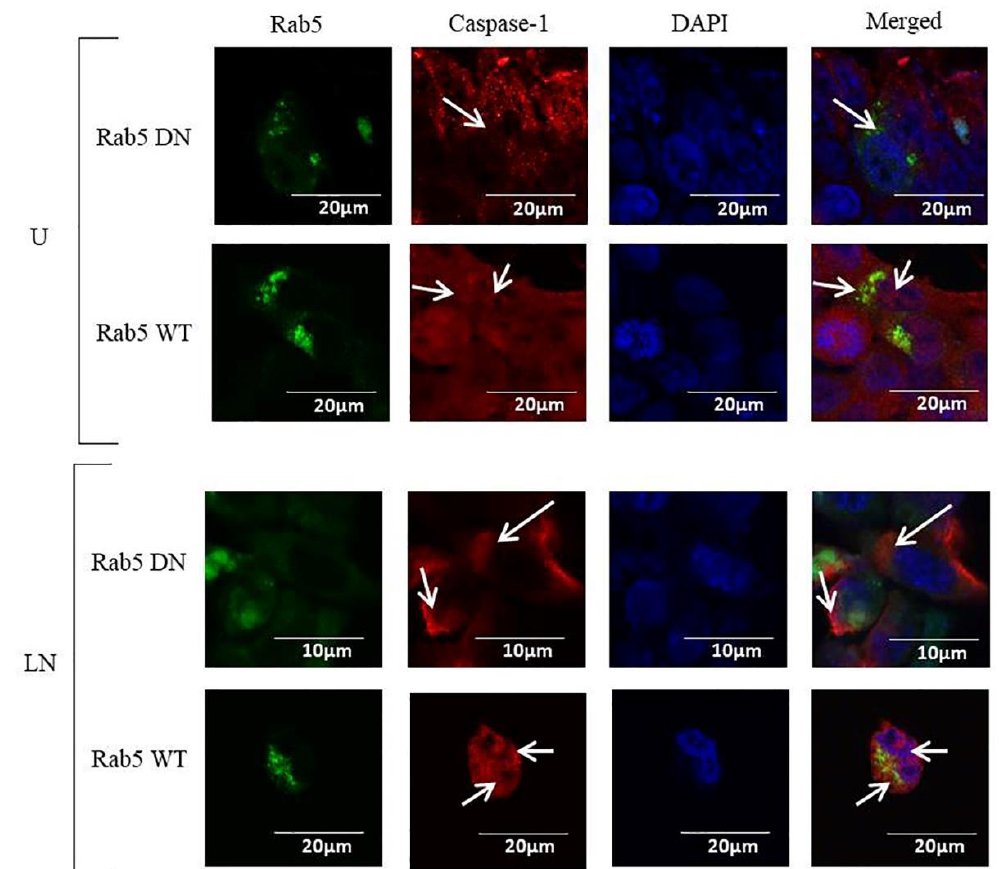
Figure 3. The e ff ects of Rab5 DN and Rab5 WT expression on caspase-1 localization. Nigericin (20 µ M) treatment for 24 h and three hours of pre-incubation with LPS (1 µ g / mL) were used to activate the NALP3 inflammasome after the transfection of pDsRed-rab5-WT and pDsRed-rab5-DN to the HCT116 cells. Caspase-1 was found only in the cytosol in the control and LPS / nigericin-treated DN Rab5 cells, while it was localized in the nuclei and cytosol in the WT Rab5 cells. Arrows show the localization of caspase-1. DN and WT Rab5 proteins were visualized using green coloring with 488 nm excitation wavelengths. Caspase-1 was visualized using a 590 nm excitation wavelength and red coloring. The nucleus was visualized using DAPI. U: untreated; LN: LPS / nigericin, DN: dominant negative; WT: wild type ( n = 3 for each experiment).